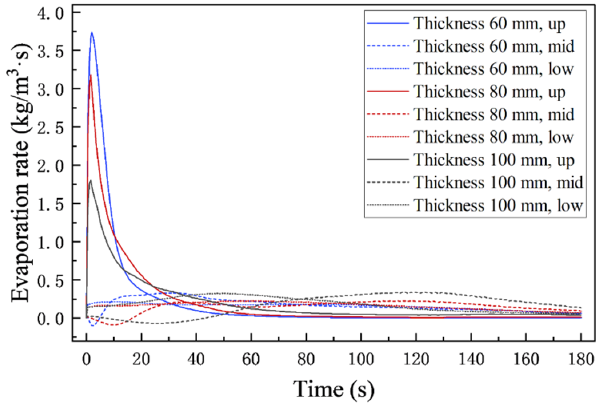
Figure 9. Average evaporation in different regions of the heaped tobacco strips models.